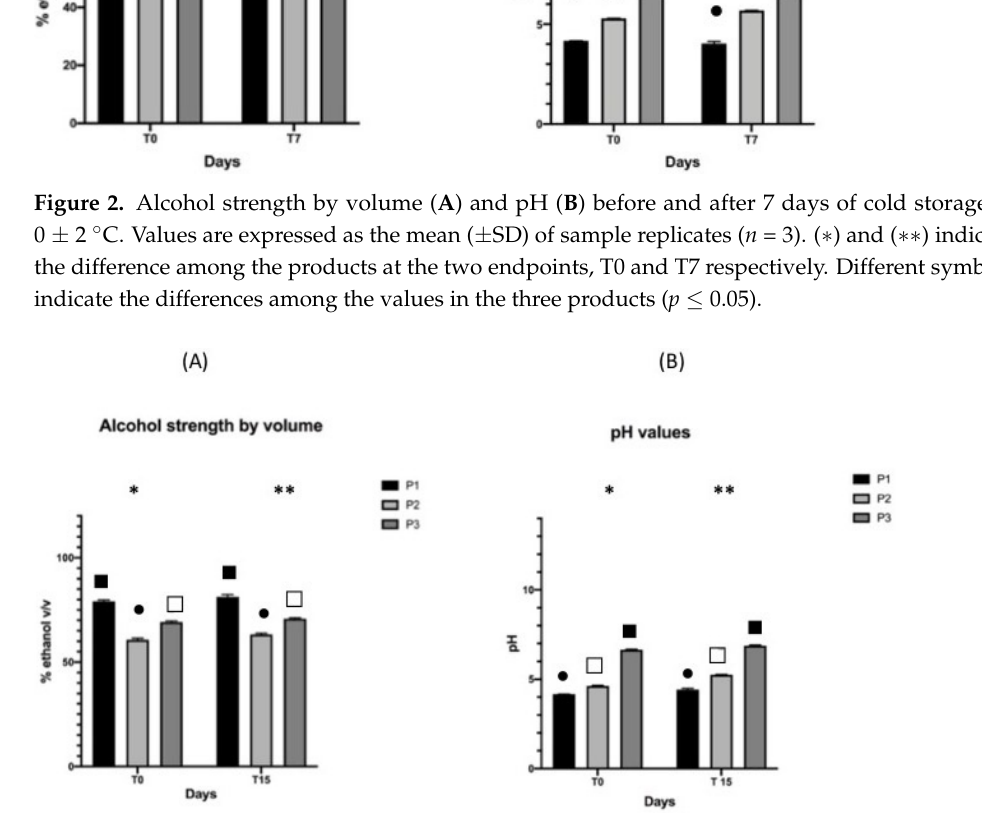
Figure 3. Alcohol strength by volume (A) and pH (B) before and after 15 days of hot storage at 52 ± 2 °C. Values are expressed as the mean (±SD) of sample replicates ( n = 3). ( ∗ ) and ( ∗∗ ) indicate the difference among the products at the two endpoints, T0 and T7 respectively. Different symbols indicate the differences among the values in the three products ( p ≤ 0.05).